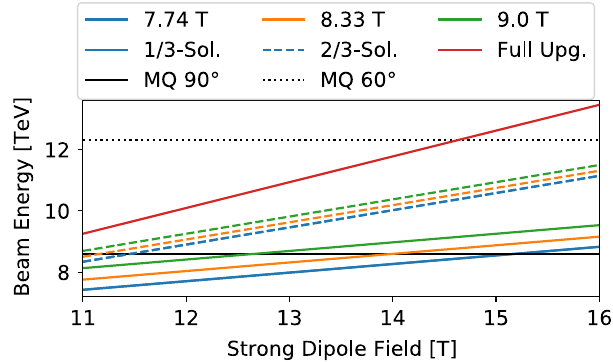
FIG. 7. Reachable beam energy for various 1 = 3 solutions (solid lines), 2 = 3 solutions (dashed lines), assuming 7.74 T (blue), 8.33 T (orange), or 9 T (green) weak dipole fields, together with a full upgrade (red). The maximum beam energy compatible with the main quadrupoles limits is 8.6 and 12.3 TeV for a 90° and a 60° arc-cell phase-advance design, respectively.